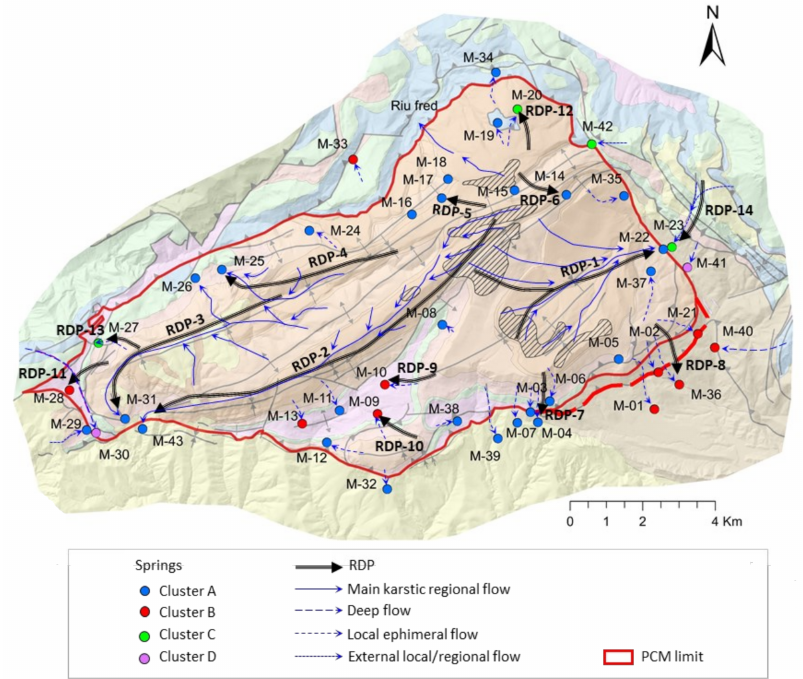
Figure 3. Recharge-Discharge Pathways (RDPs) considered on the geological map (Figure 1), to be an- alyzed with PHREEQC. The cluster associated to every RDP coincides with that of the corresponding discharge spring. The GW flow lines are only